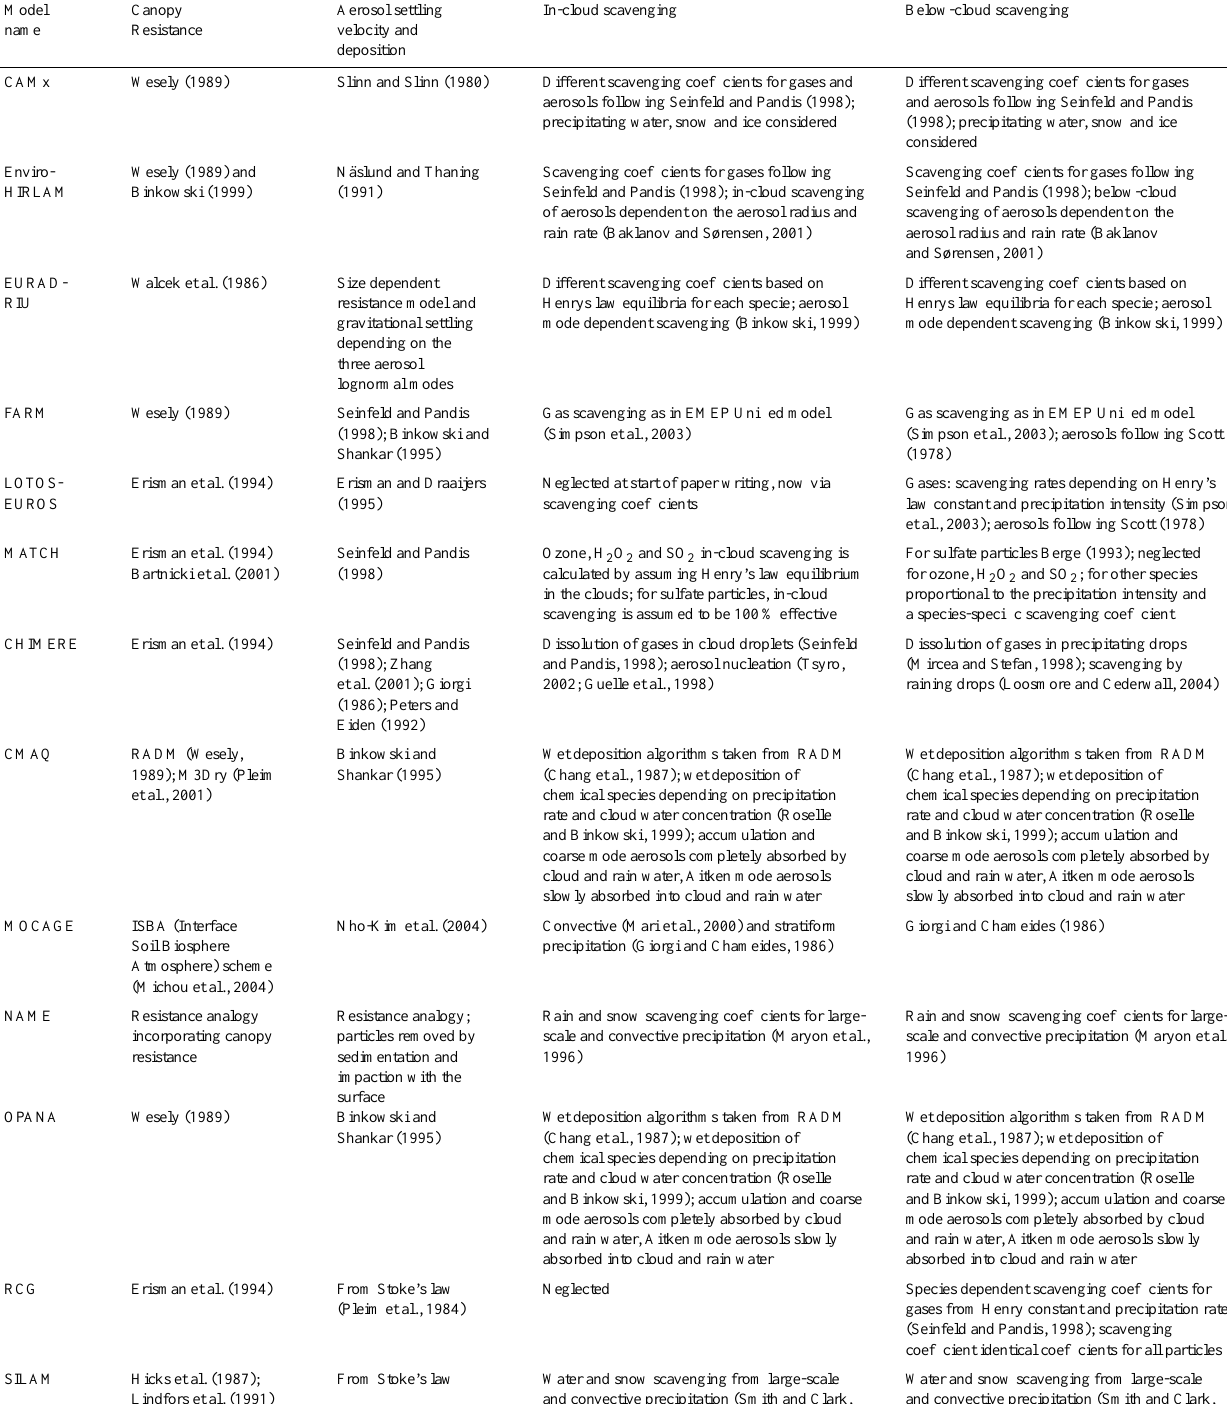
Model Below-cloud scavenging